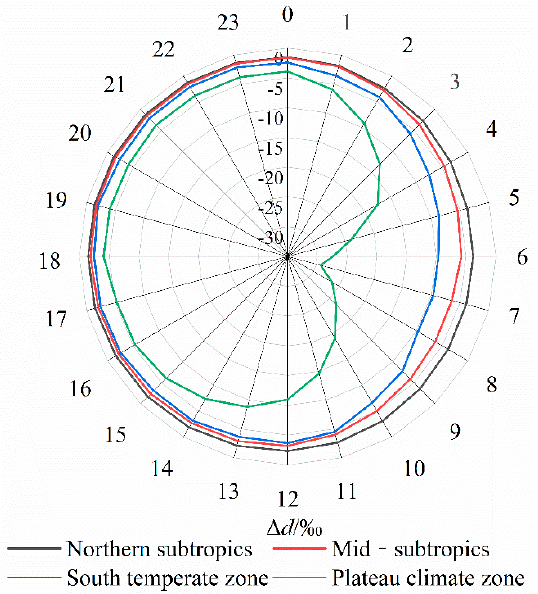
Figure 2. Hourly variation of ∆ d in the Yangtze River Basin. Each climate zone is marked with different colors: northern subtropics (gray), mid-subtropics (red), south temperate zone (blue), and plateau climate zone (green).